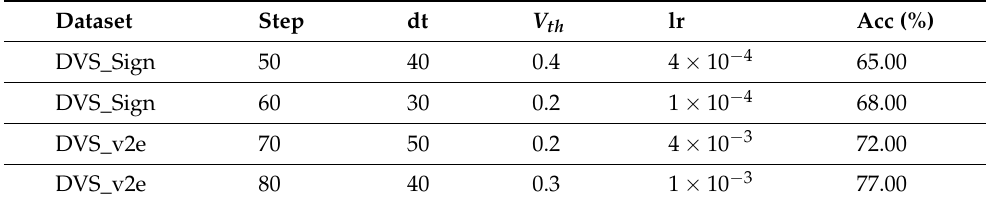
Table 3. Comparison of parameters corresponding to the training